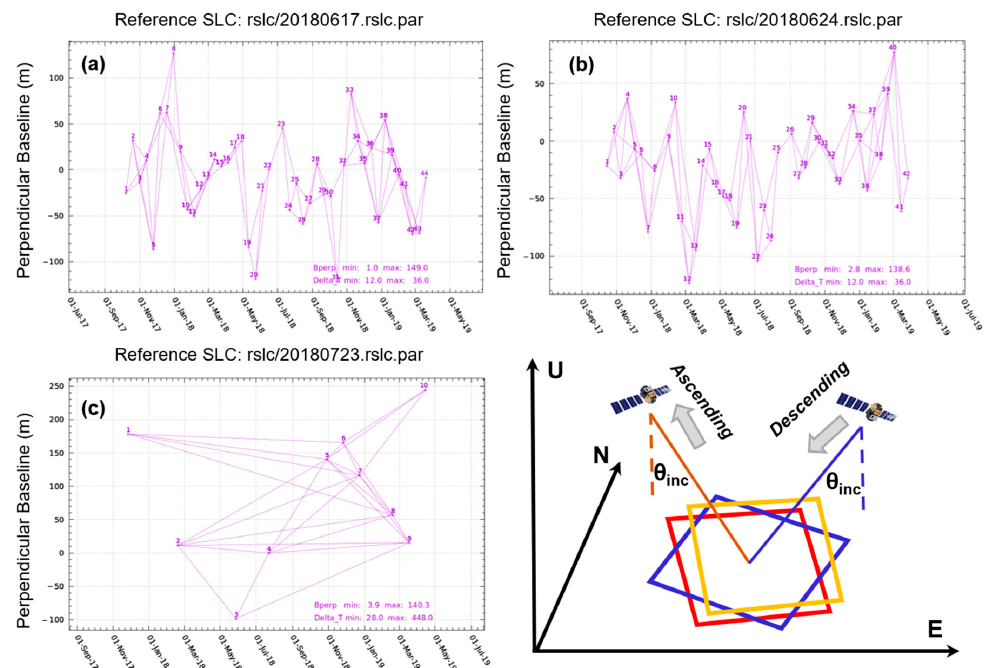
Figure 3. Baselines of the three orbits used in this study. ( a ) Baseline of Sentinel-1 ascending images; ( b ) baseline of Sentinel-1 descending images; ( c ) baseline of PALSAR-2 ascending images.